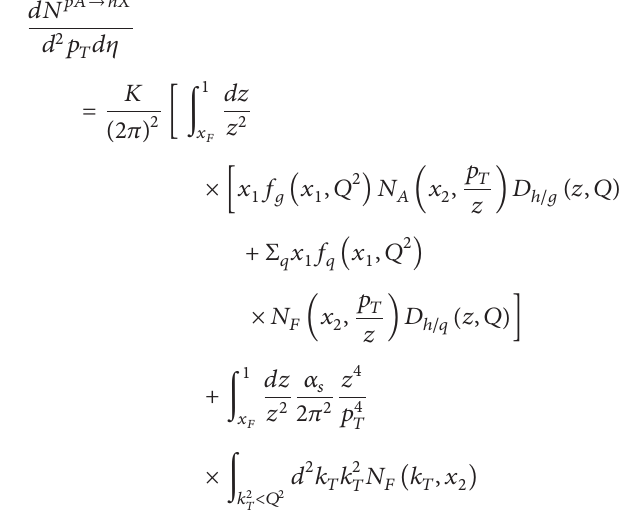
𝛾 ∗ 𝑝 2 where 𝛼 , 𝑄 , and 𝜎 𝑇,𝐿 denote the electromagnetic em